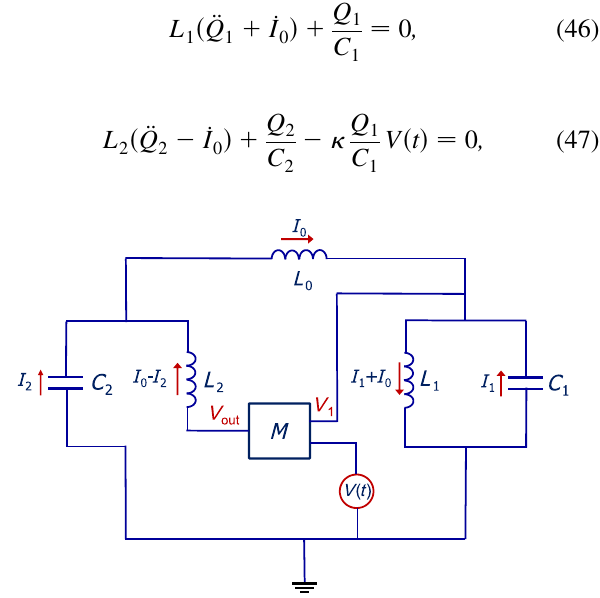
FIG. 4. Electronic circuit analog of the QASER. Two LC circuits weakly coupled by an inductor L 0 correspond to the atoms and to the field. Modulation of the coupling strength is provided by a feedback mechanism in which voltage V 1 from the capacitor C 1 is applied to the input terminal of the multiplier M; its output voltage V out is proportional to the product of the two input voltages V ð t Þ and V 1 , where V ð t Þ ¼ V 0 cos ð (cid:3) voltage produced by a function